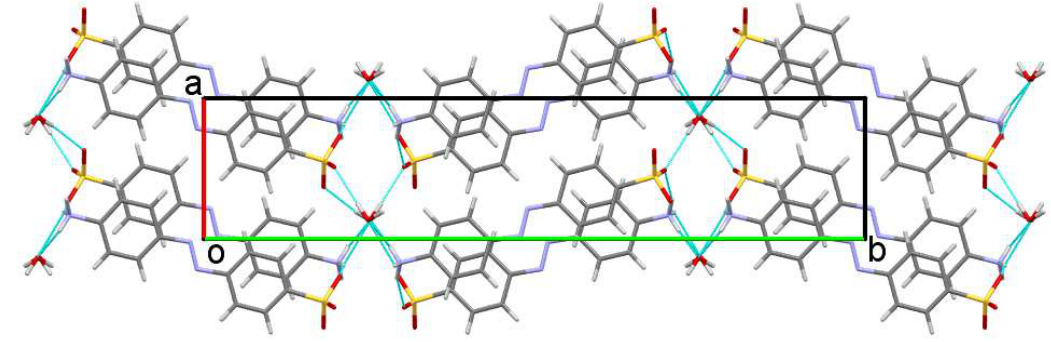
Figure 6. Packing diagram of H9 .H 2 O viewed along the c axis. Note the polar and non-polar layers lying parallel to the ac plane.